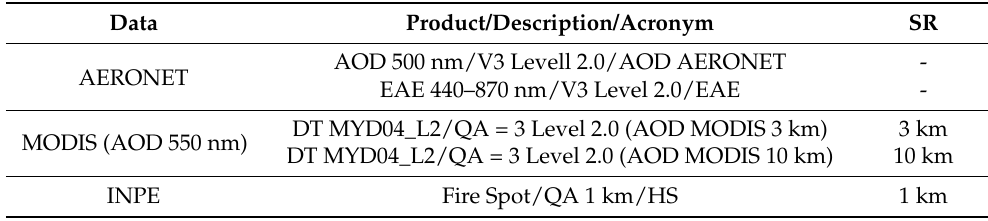
Table 1. Overview of the products used in this study, where SR stands for spatial resolution and QA is the quality